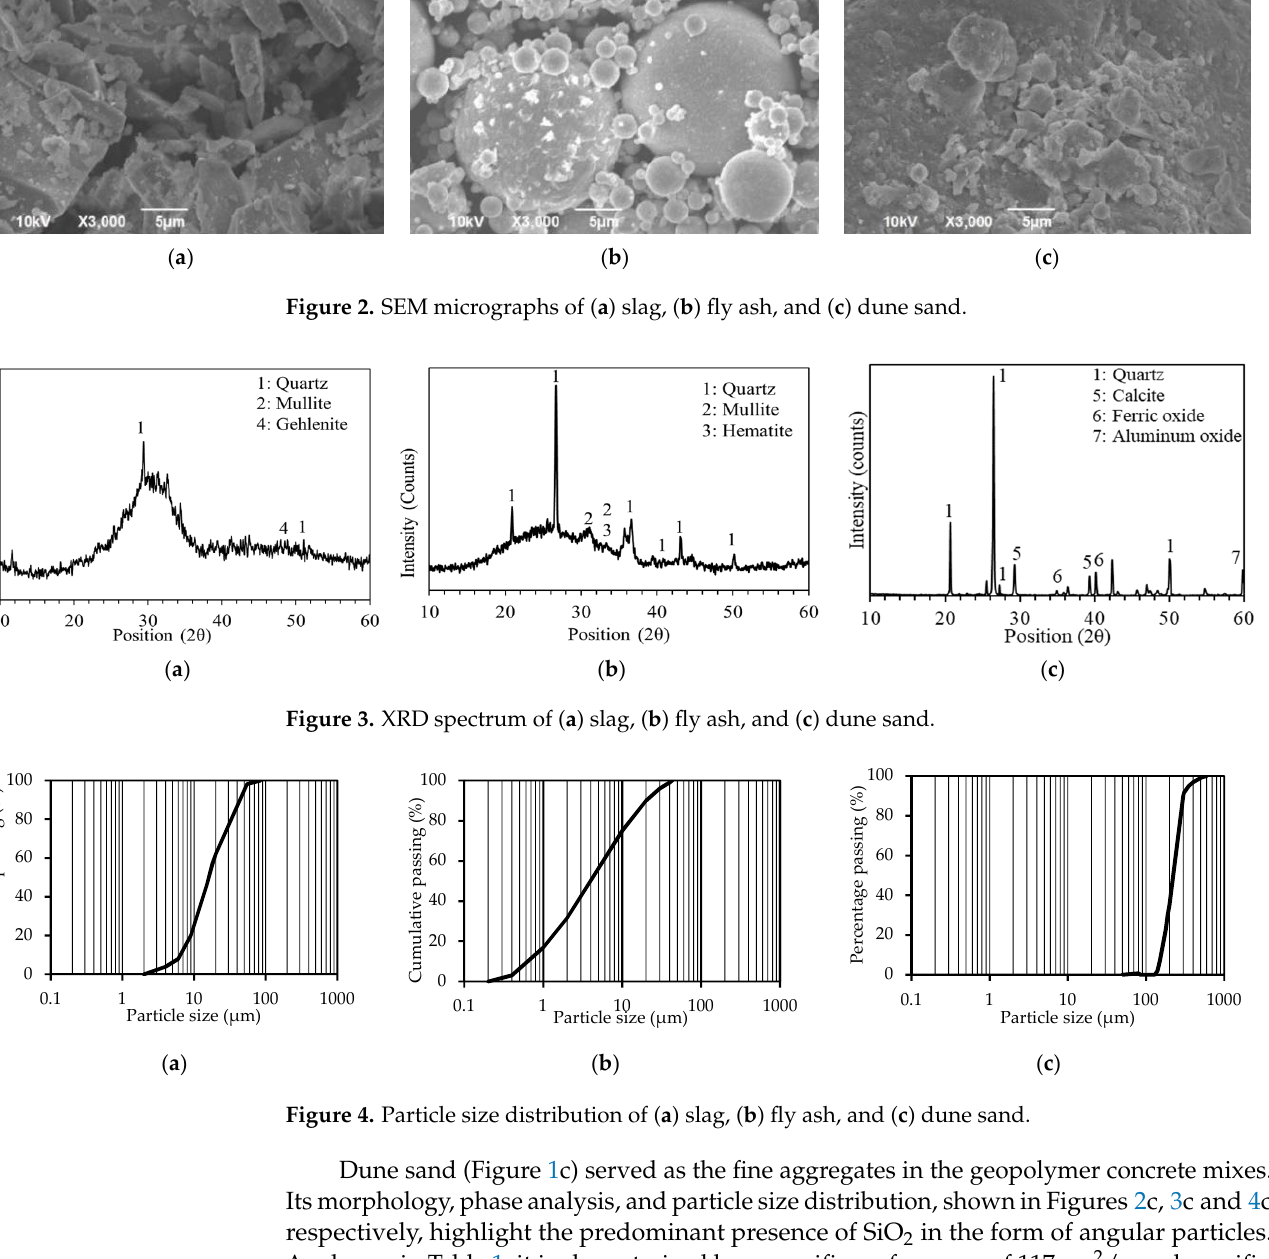
Figure 4. Particle size distribution of ( a ) slag, ( b ) fly ash, and ( c ) dune sand. Table 2. Physical properties of natural aggregates (NA).